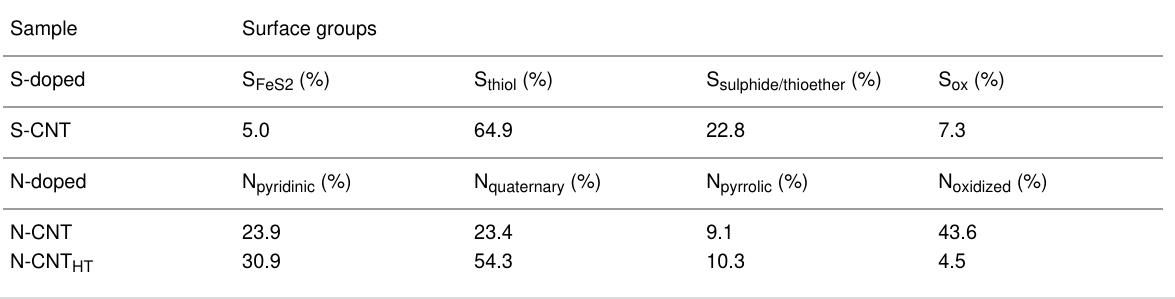
Table 2: Contribution of species detected by deconvolution of XPS spectra for several N-CNT samples.